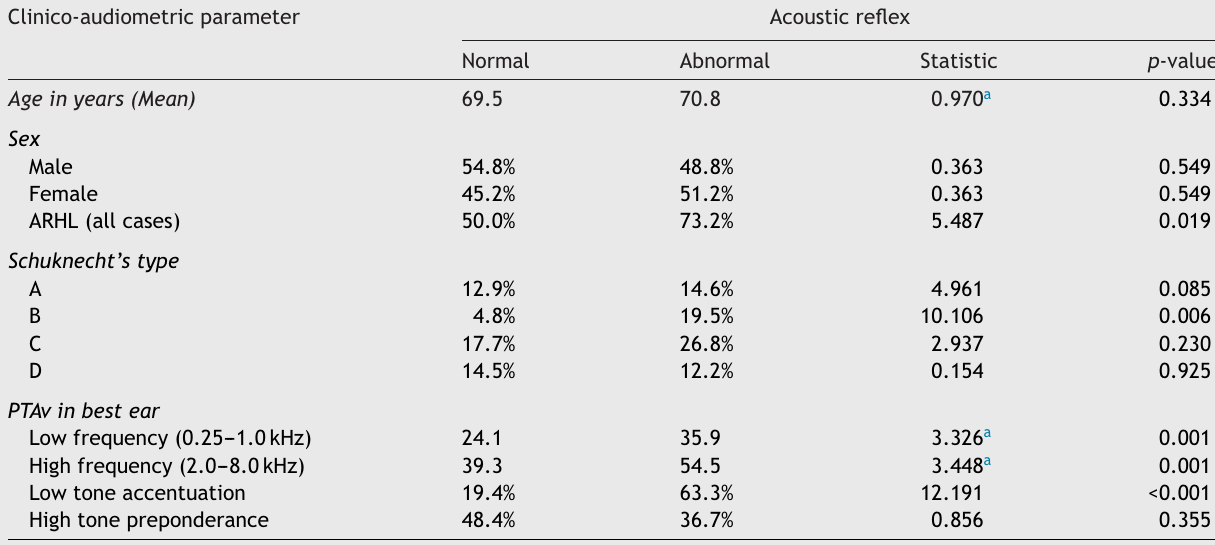
Relationship between clinico-audiometric findings and acoustic reflexes. Clinico-audiometric